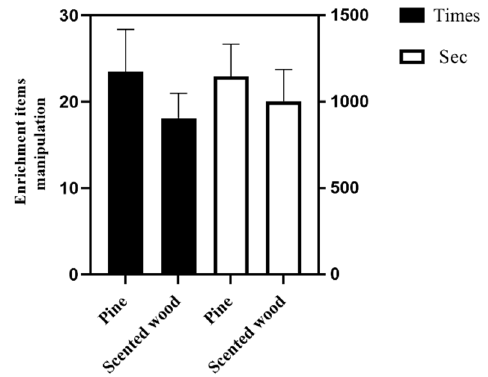
Figure 5. The manipulation frequency and duration of enrichment items. The data are expressed as mean ± SEM (n = 10).